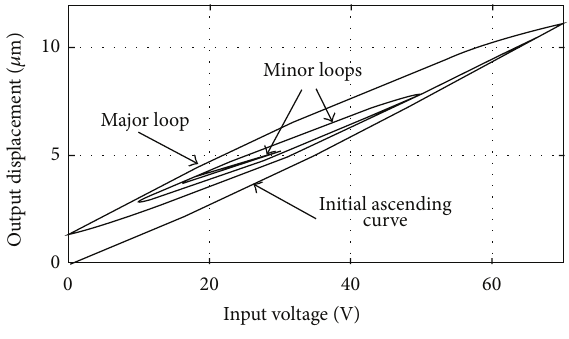
Figure 22: Hysteresis of a PEA [21].